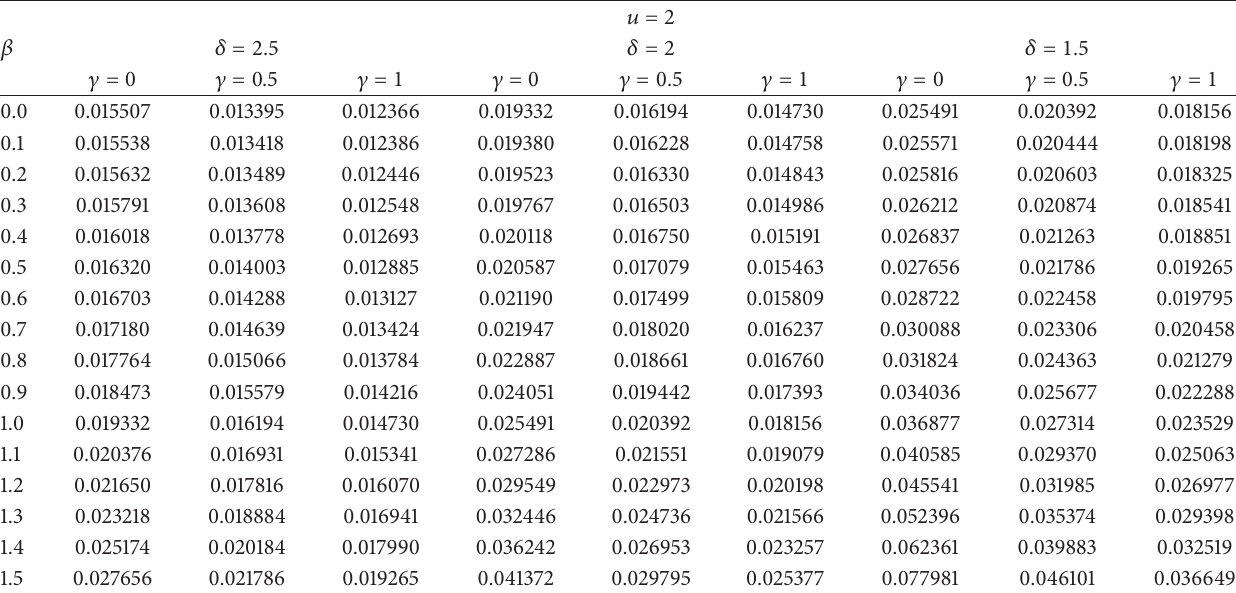
Table 2: Exact values of 𝜙 1 (𝑢) under different stochastic interest models. 𝑢 =